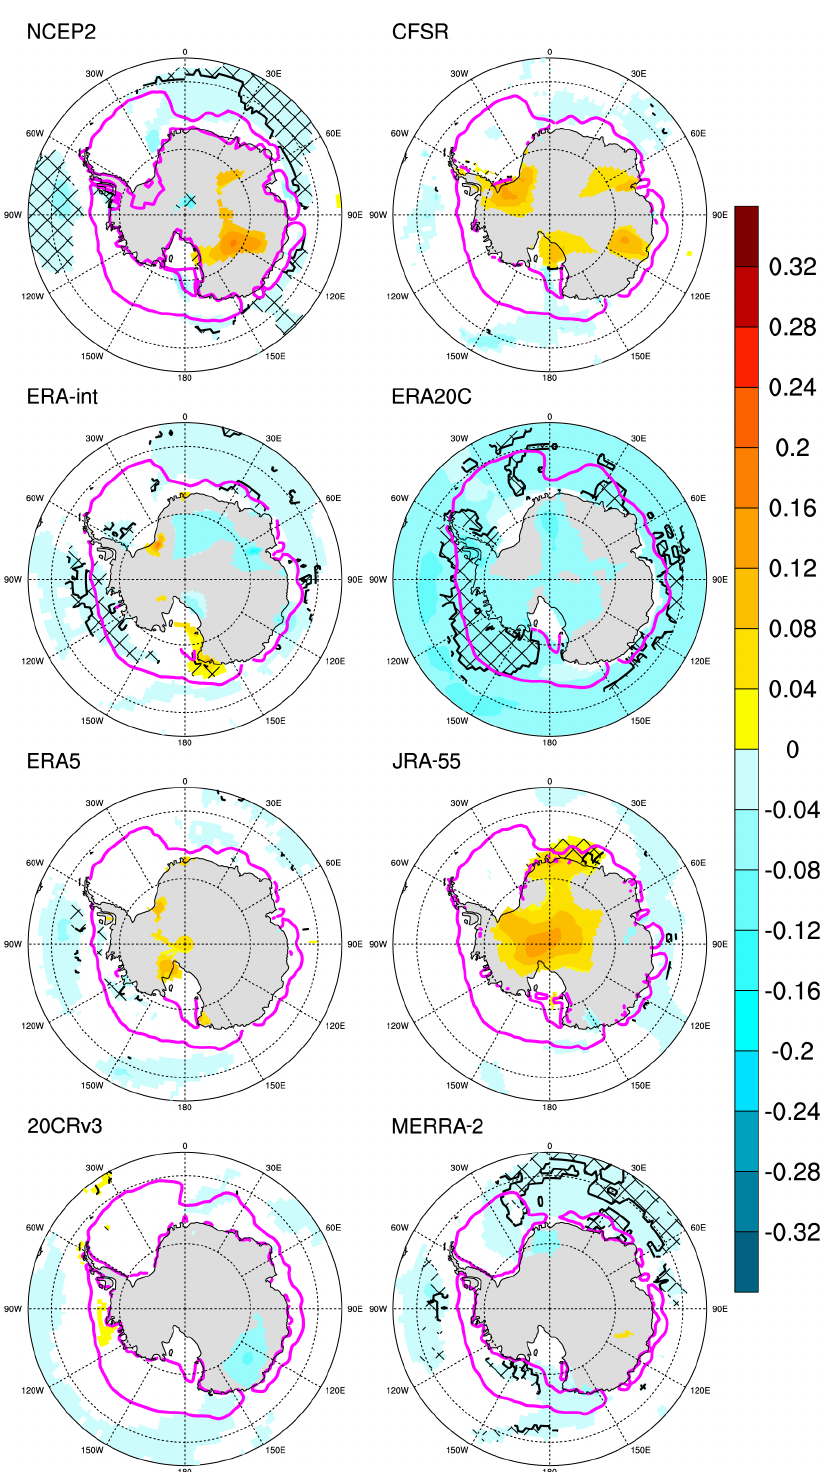
Figure 5. Panels (a) – (h) 1980–2010 December–January mean reanalysis SAT trends over the climatological sea ice zone ( ◦ C/year); only trends that are statistically significant at the 90% level are shown. Hatched regions show where the signs of statistically significant reanalysis SIC and SAT trends are the same (i.e. the unexpected result of both a warming (cooling) and an increase (decrease) in sea ice cover). The magenta line shows the climatological sea ice